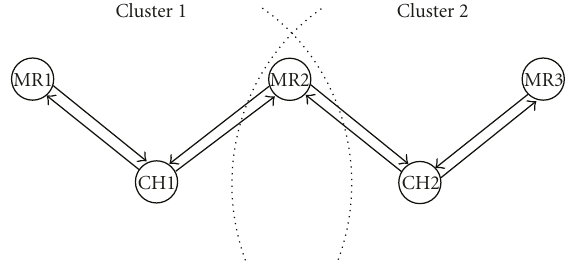
Figure 2: The mesh network topology is organized in clusters. Each cluster is controlled by a cluster head (CH). Other nodes in the network are called mesh routers (MR) since they can be used to relay information between CHs.